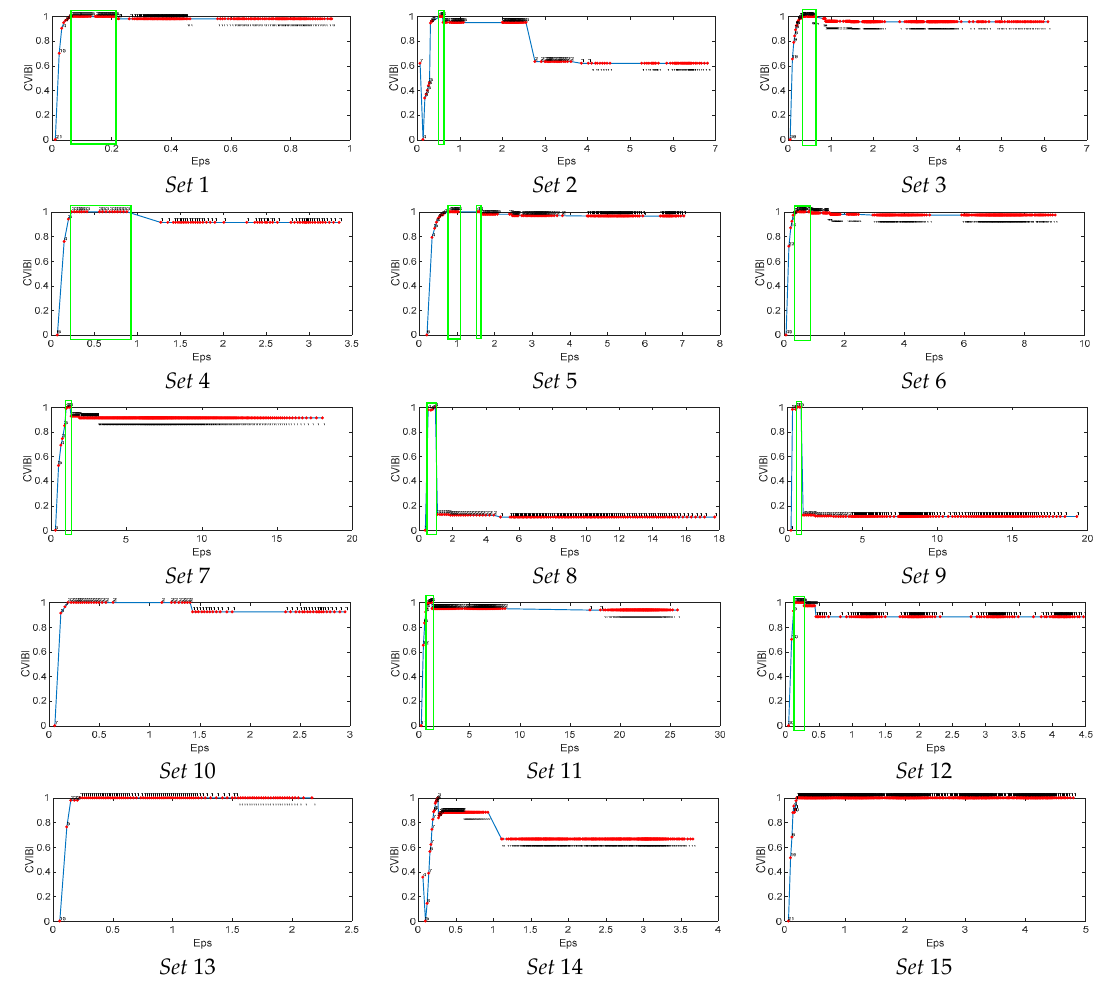
Figure 11. Evaluation results of CVIBI based on DBSCAN.